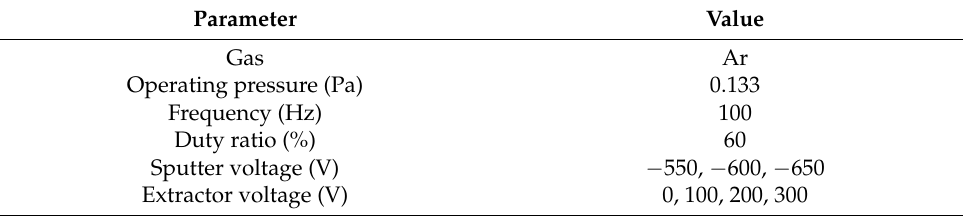
Table 1. Experimental